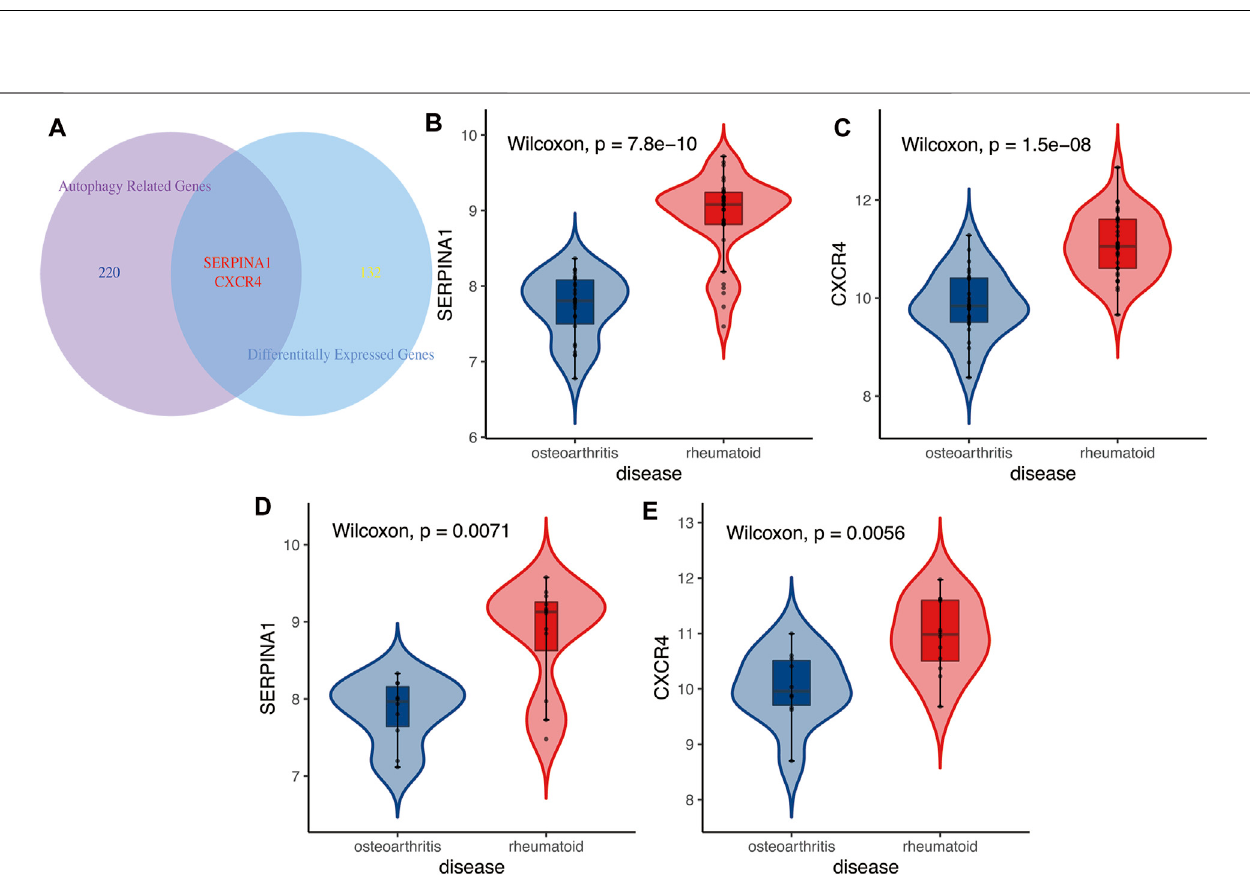
FIGURE 4 | ( A ) The Venn diagram between differentially expressed genes and autophagy-related genes. Results showed autophagy-related genes CXCR4 and SERPINA1 weredifferentiallyexpressed inRAandOA. (B,C) Trainingcohort.Autophagy-related genes CXCR4 and SERPINA1 werehigherexpressedinRAthaninOA. (D,E) Testingcohort.Resultsofdifferentialexpressionsofautophagy-relatedgenes CXCR4 and SERPINA1 alsoveri fi edinvalidationcohort,higherexpressedinRAthan in OA.